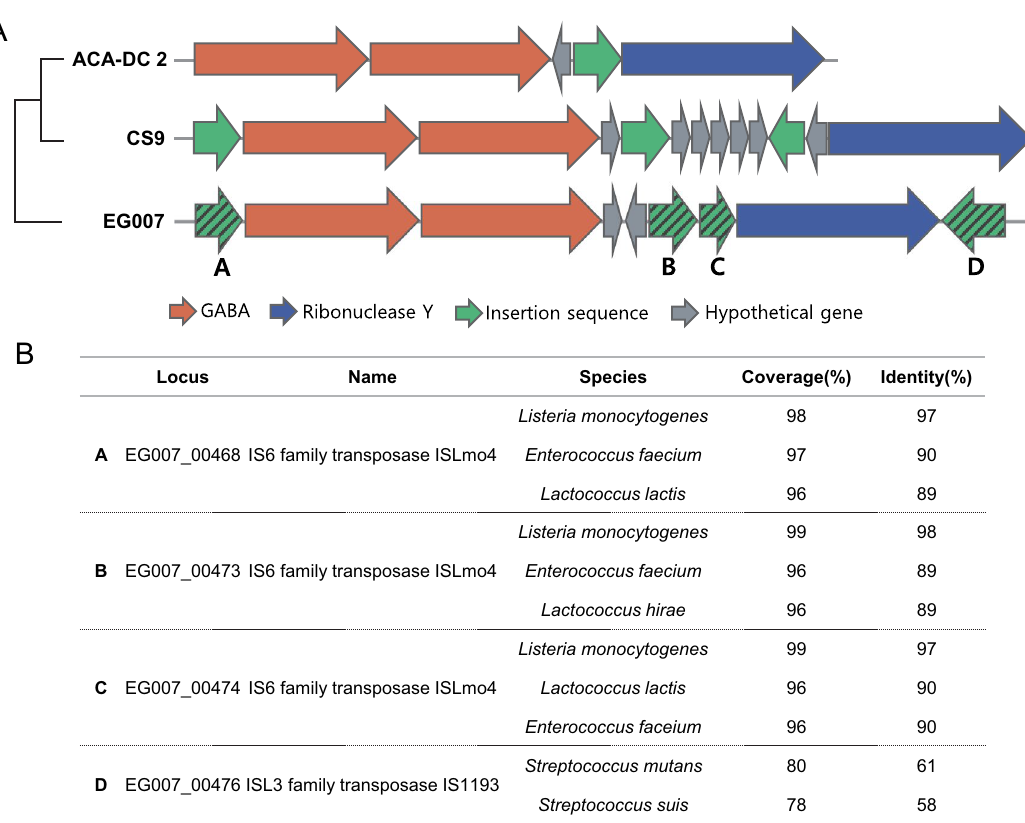
Figure 3. Gene organization around GABA producing operon. ( A ) Varied organization around GABA gene operon among S. thermophilus EG007, CS9, and ACA-DC-2. Genes encoding the related proteins are marked with a different color. ( B ) Similarity search results of insertion sequences flanking GABA gene operon of